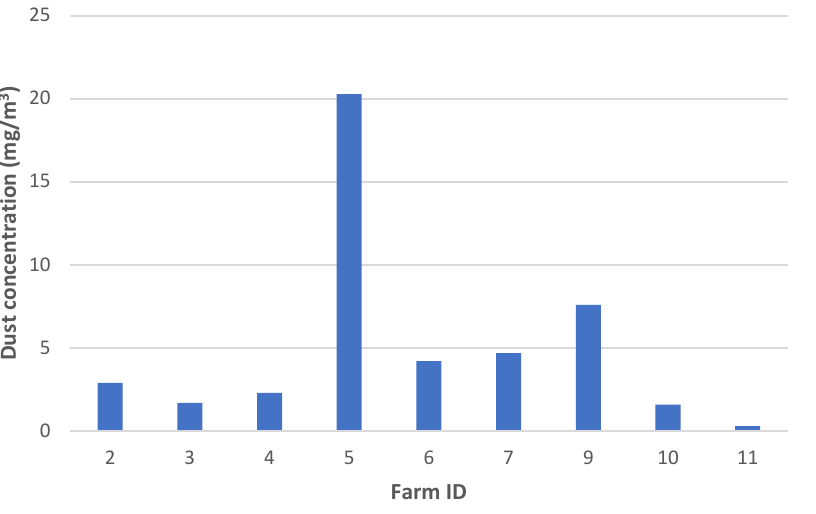
Figure 2. The total dust concentration (mg/m 3 ) measured during the farm visits using the gravimetric principle (i.e., the reference method). No data were obtained during visits to Farms 1 and 8 due to failure of the device.